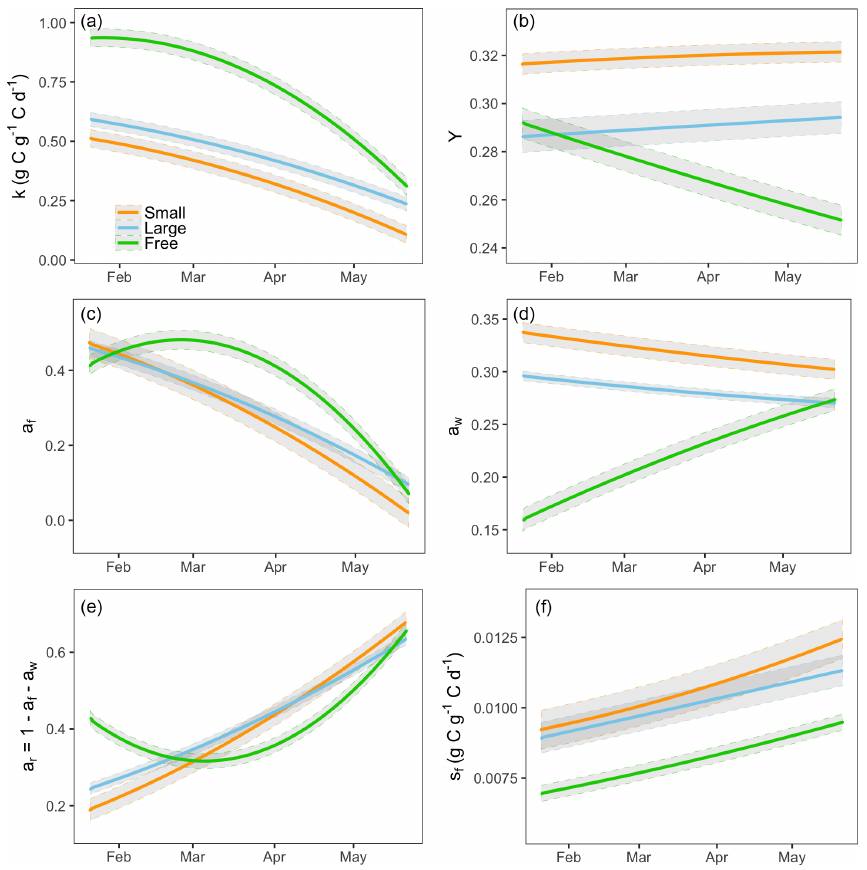
Figure 3. Modeled final parameters for three groups of treatments during the experiment period (21 January to 21 May 2013): (a) storage utilization coefficient, k ; (b) growth respiration fraction, Y ; (c) allocation to foliage, a f ; (d) allocation to wood, a w ; (e) allocation to roots, a r ; and (f) leaf turnover rate, s f . a r is defined as 1 − a f − a w . The gray shaded area shows the 95% confidence intervals of modeled